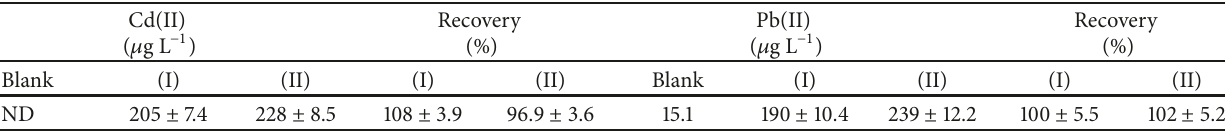
Table 3: Recovery of Cd(II) and Pb(II) in battery industry wastewatersample fortified in two concentrationlevels: (I) 190 𝜇 g L −1 and (II) 235 𝜇 g L −1